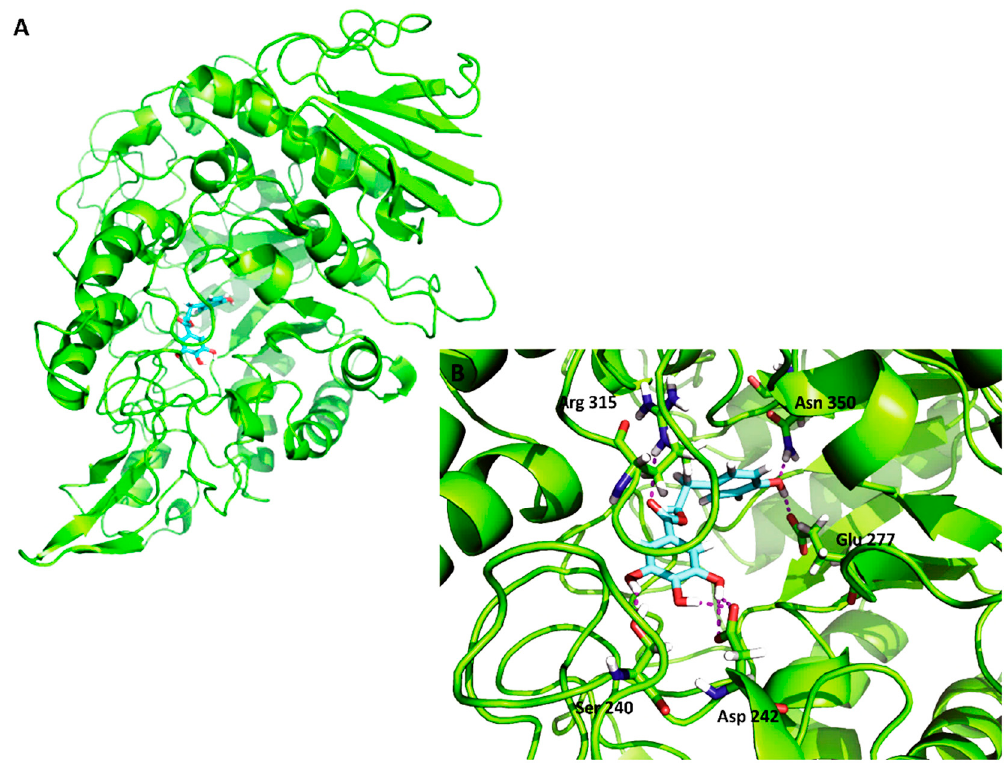
Figure 6. Proposed structural model of maltase-HETB complex. ( A ) HETB, maltase, and oxygen atoms are shown in light blue, green, and red, respectively. ( B ) The nitrogen atoms, oxygen atoms, and hydrogen atoms are labeled in blue, red, and white, respectively.